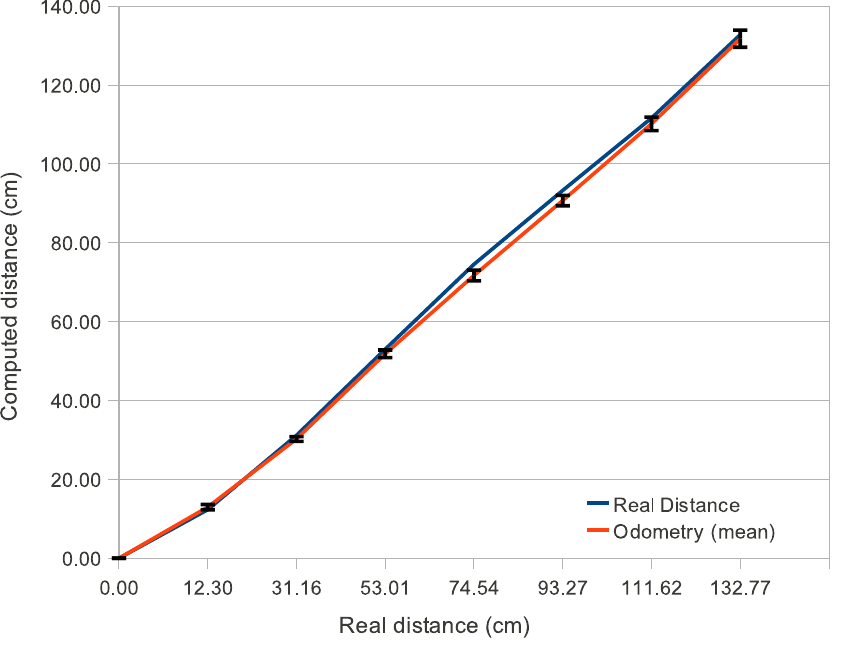
Figure 6. Experimental odometry results. X axis is the real traveled distance manually measured with a tape measure. Y axis is the distance computed by the mobile device using the proposed system with data from the